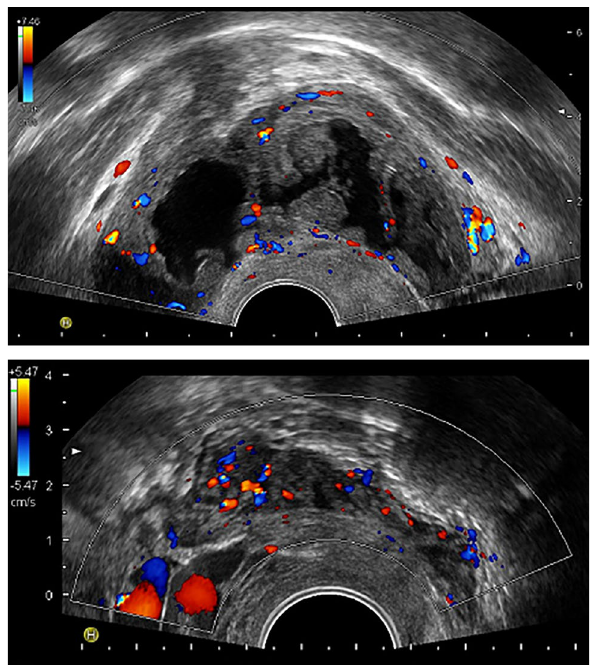
Figure 1. Decidualization of ovarian endometriomas and deep peritoneal nodules. In the upper panel, a decidualized endometrioma at 12 weeks’ gestation is shown (Case 6 left, see Table 3). Multiple vascularized papillary vegetations can be observed. Their color score was quoted as 2. In the lower panel, a retrocervical endometriotic nodule at 23 weeks’ gestation is represented (Case 15, see Table 4). The mean diameter of the lesion increased from basal evaluation to 23 weeks’ gestation from 25 to 29 mm. Doppler evaluation showed a color score of 3 (at baseline it was 1).